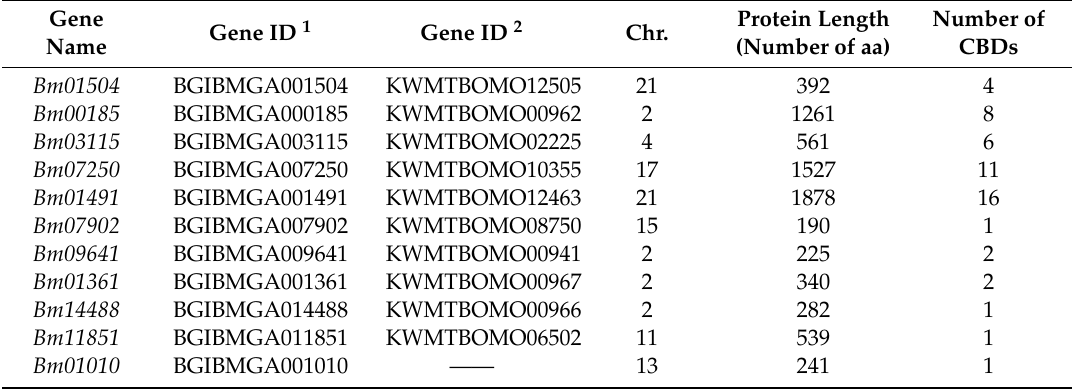
Table 1. List of the peritrophins detected in the genome of Bombyx